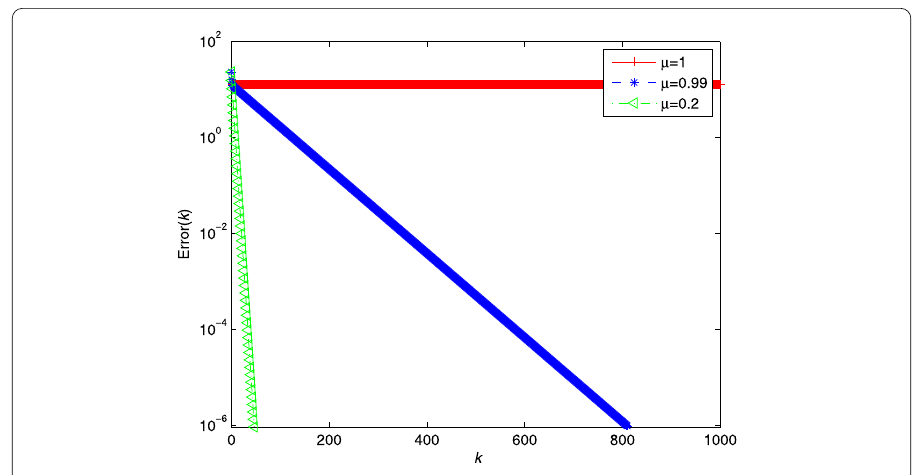
Figure 1 Numerical results of iterative scheme (2.2)–(2.4) with different